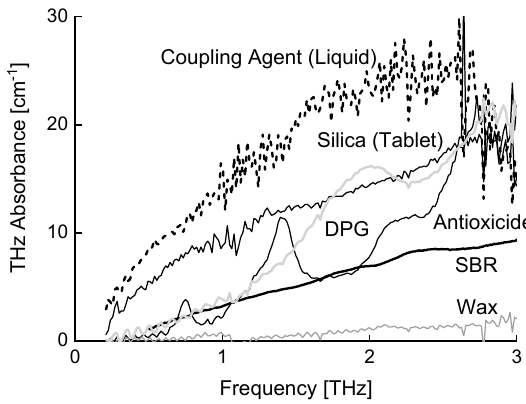
Figure 7. THz absorbance spectra for newly measured agents.